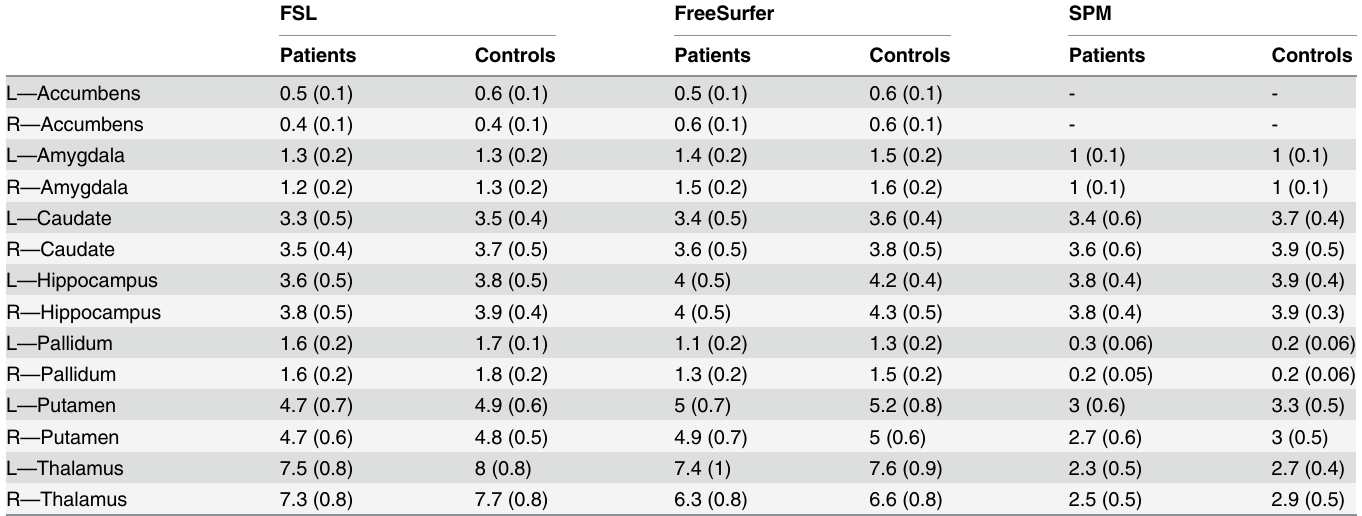
Table 3. DGM volumes (mL) with all software